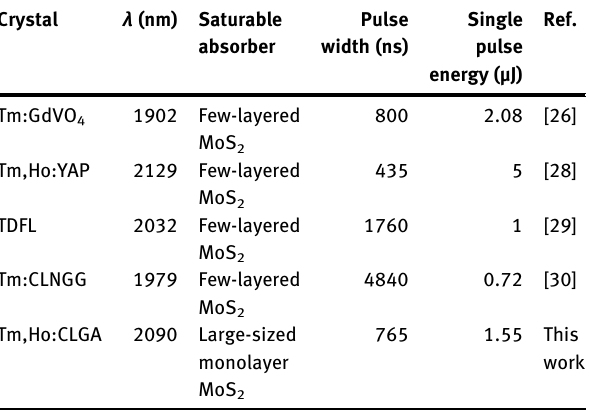
Table  : Comparisons of the Q-switched laser performance at  μ m with previous reported